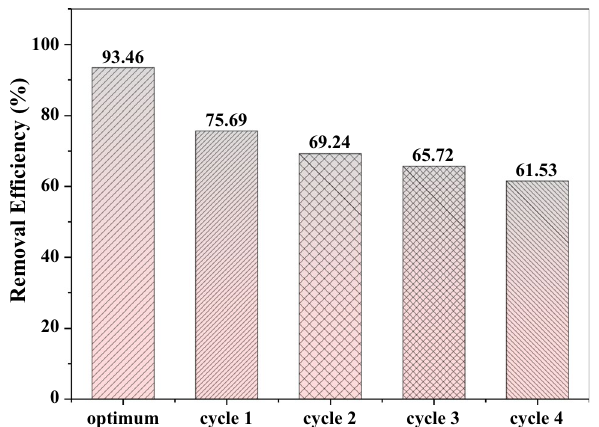
Fig. 6 Recovery and reuse diagram for activated carbon on cationic red 14 dye removal